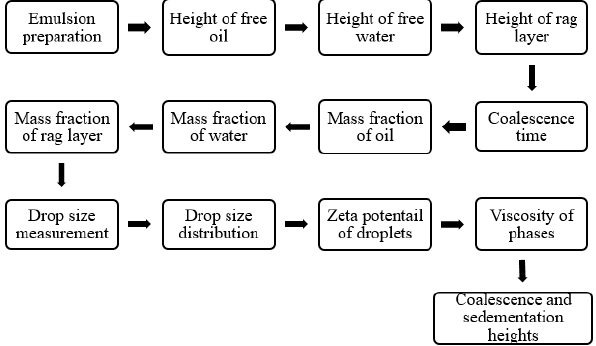
Figure 2. Measuring principle of Turbiscan or experimental measurement of separation from the emulsion sample by sedimentation (back scattering) and coalescence (light transmission). Figure 3. Procedure of the sedimentation and coalescence measurements.